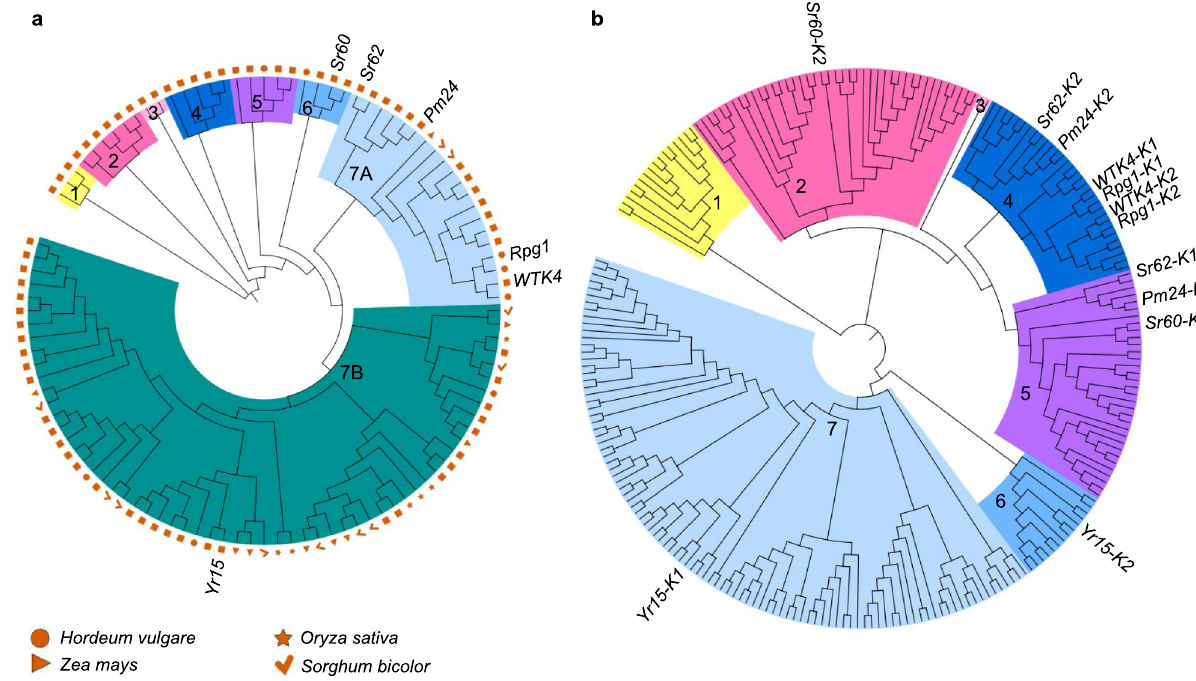
Fig. 4 Phylogenetic relationship between tandem kinases from cereal crop and wild grasses. A total of 99 predicted tandem kinases were retrieved from the genomes of bread wheat, durum wheat, maize, barley, sorghum, rice, Ae. tauschii and Ae. sharonensis , along with the fi ve cloned tandem kinase disease resistance genes. Phylogenetic clades and subclades are indicated by different colours and labelled with numbers. a Phylogeny based on the whole tandem kinase coding sequence. b Phylogeny based on the individual protein kinase domain coding